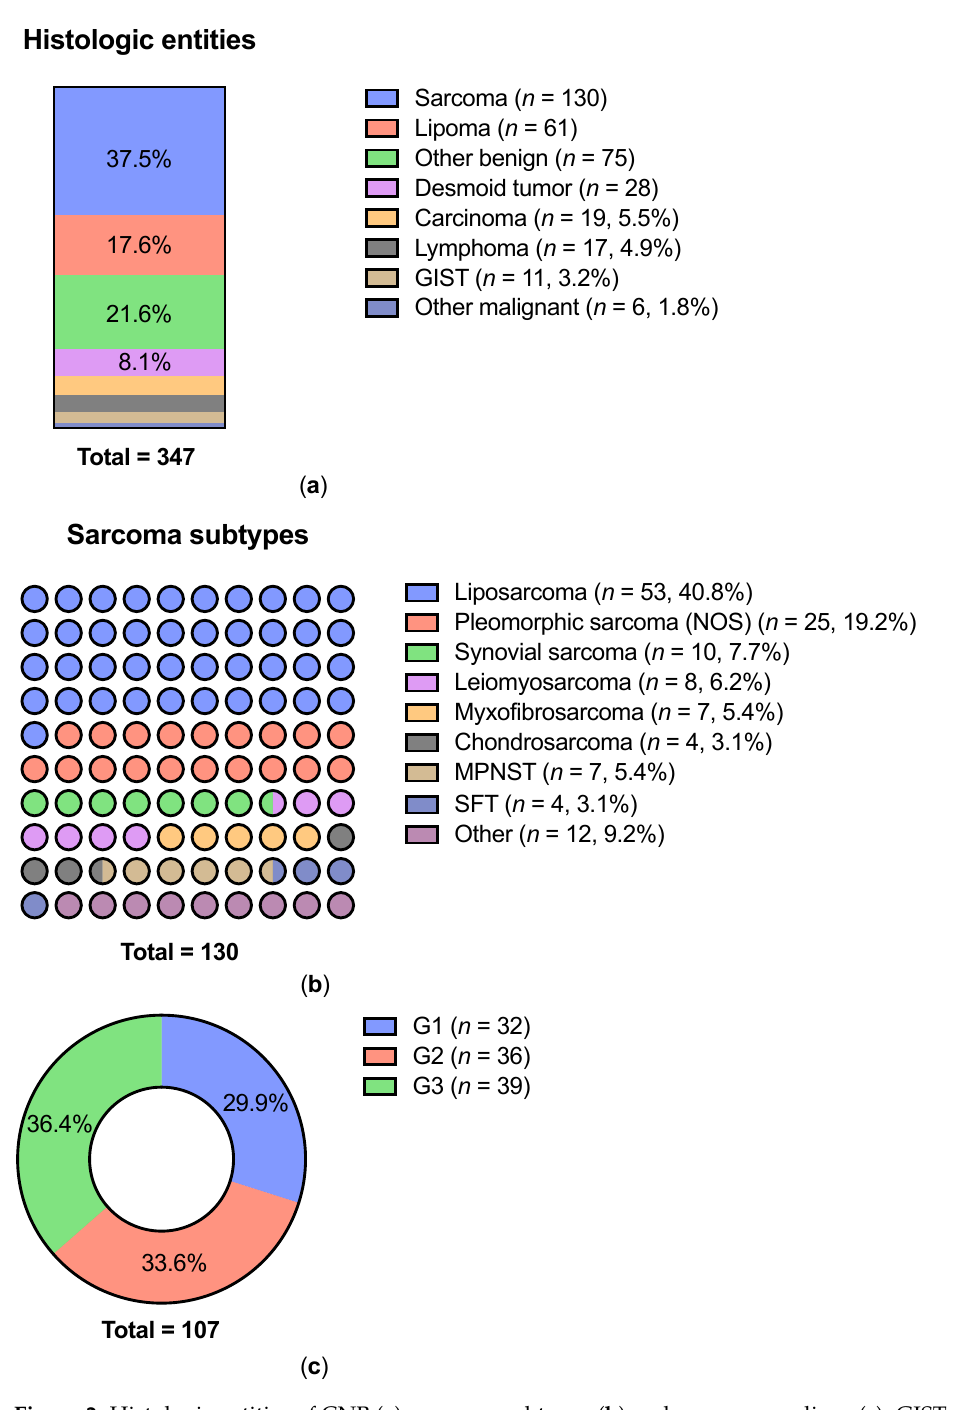
Figure 2. Histologic entities of CNB ( a ), sarcoma subtypes ( b ) and sarcoma gradings ( c ). GIST: gas- trointestinal stromal tumor; MPNST: malignant peripheral nerve sheath tumor; NOS: not otherwise specified; SFT: solitary fibrous